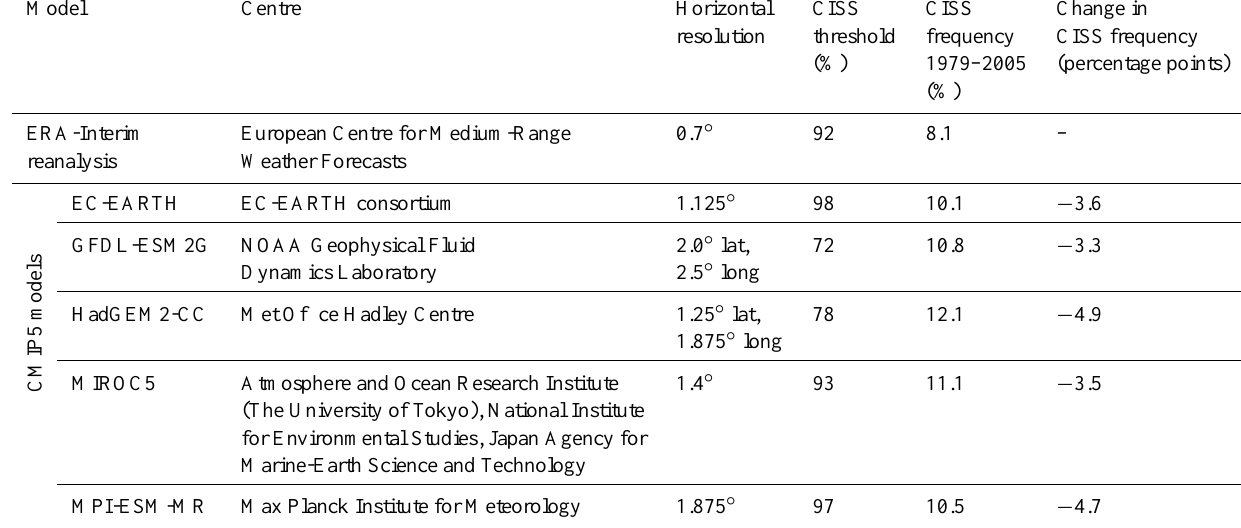
Table 1. Characteristics of the CMIP5 models used in this study. The CISS threshold is the threshold RHi value used in the calculation of the annual-mean, global-mean CISS frequency at 250hPa in the present-day climate (note a temperature threshold of 233K is also applied). The change in CISS frequency (in percentage points) is calculated as the global-mean, annual-mean CISS frequency in the RCP8.5 simulation over the period 2073–2099 minus that in the historical simulation over the period 1979–2005.